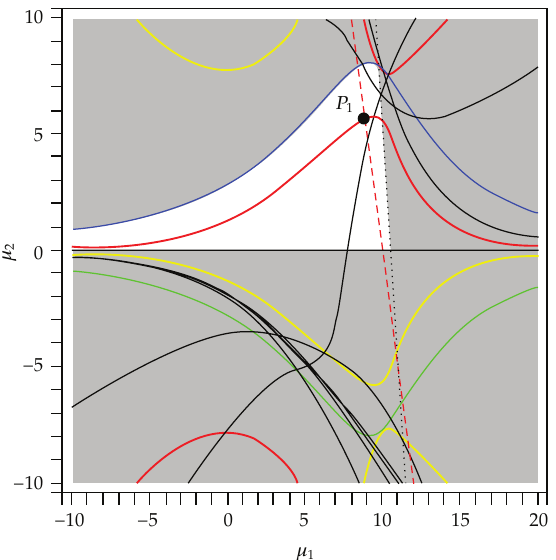
Figure 3: The illustrated conditions (cid:4) T1 (cid:5) – (cid:4) T3 (cid:5) of matrix (cid:4) 4.3 (cid:5) in Example